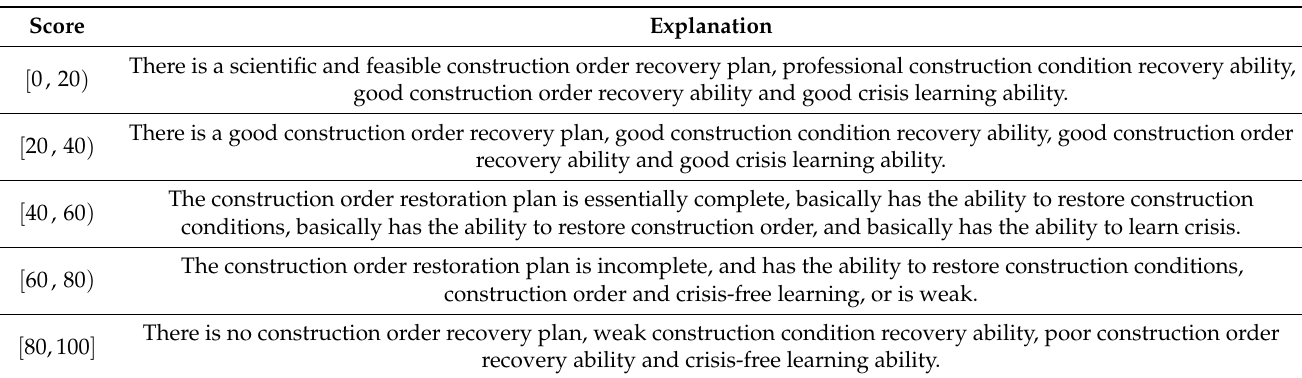
Table 3. Score basis of the management ability of participating